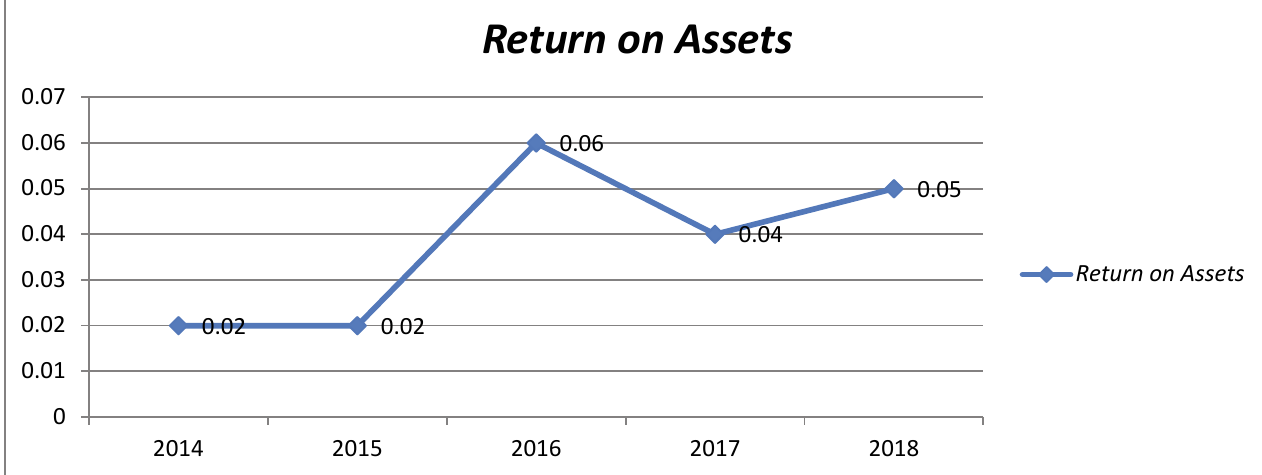
Fig. 1. Return on Assets (ROA) in the Trade, Services and Investment Sub Sector from